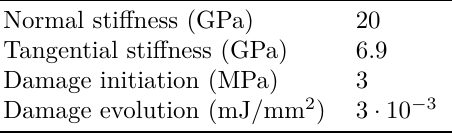
Figure 2. Undulation paths of the braided yarns modelled with a tapered cosine function following an arbitrary spline.